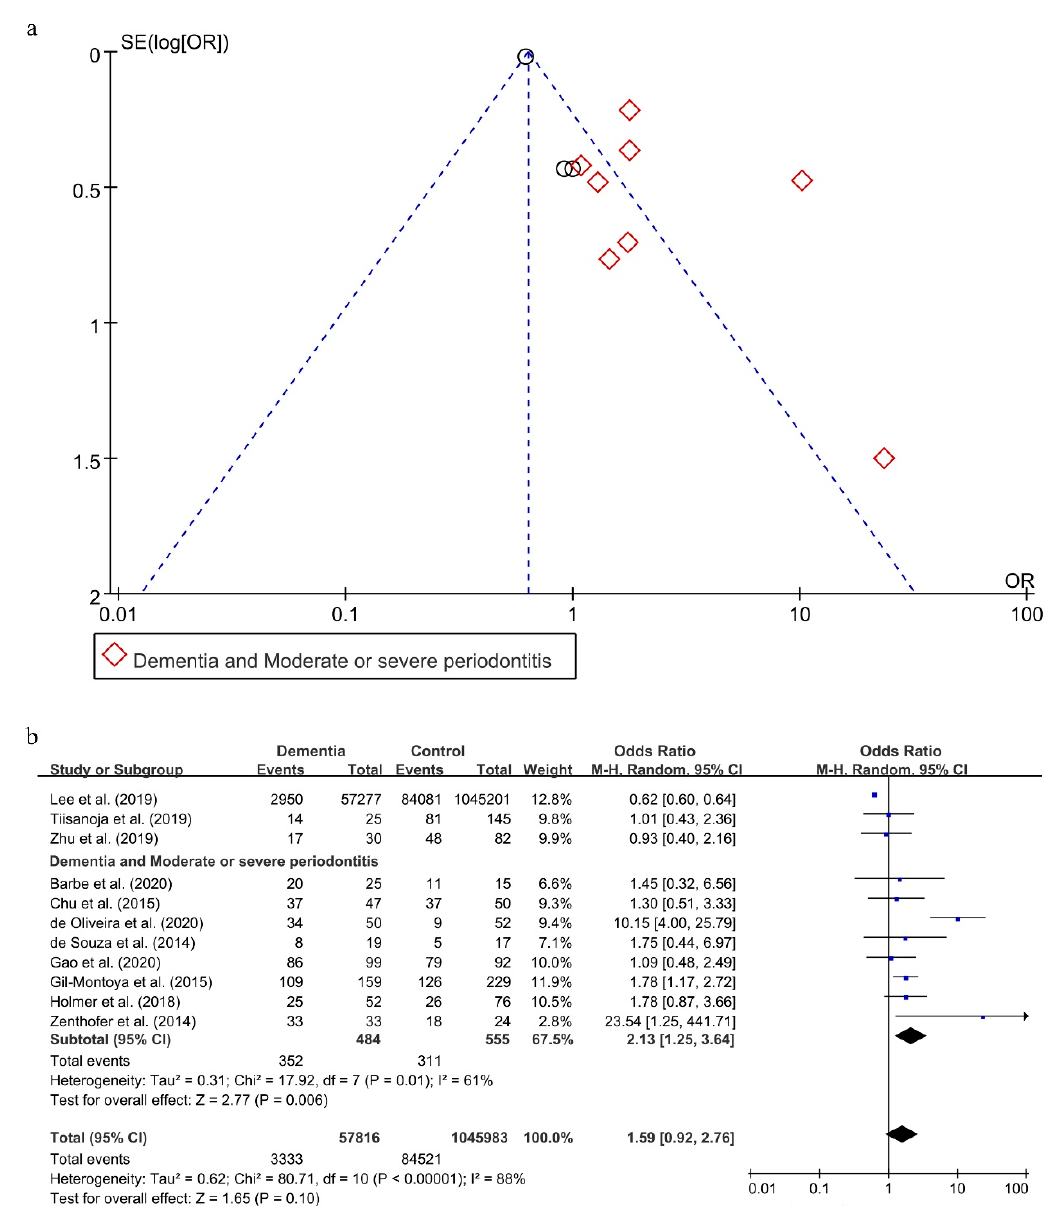
Figure 4. Funnel Plot ( a ) and forest plot ( b ) of the relationship between dementia and periodontitis.